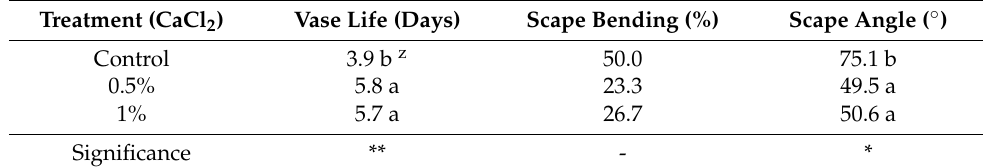
Table 1. Effects of preharvest spraying of CaCl 2 on the vase life and scape bending symptoms of gerbera ‘Harmony’ cut flowers.